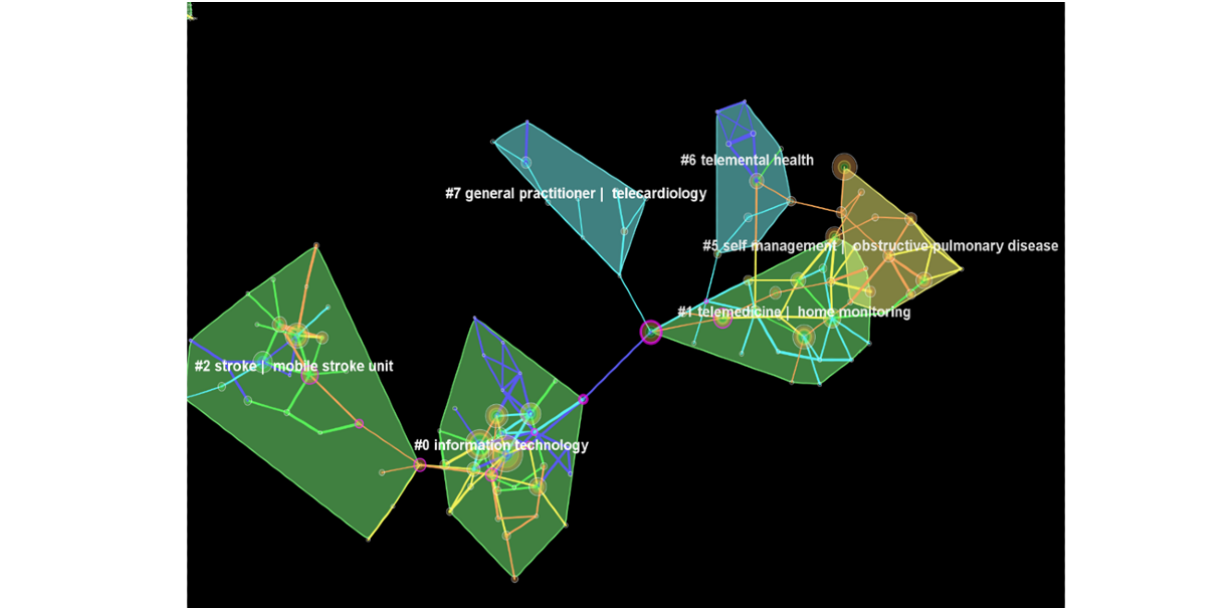
Figure 7. Clusters of research in telemedicine from 2009 to